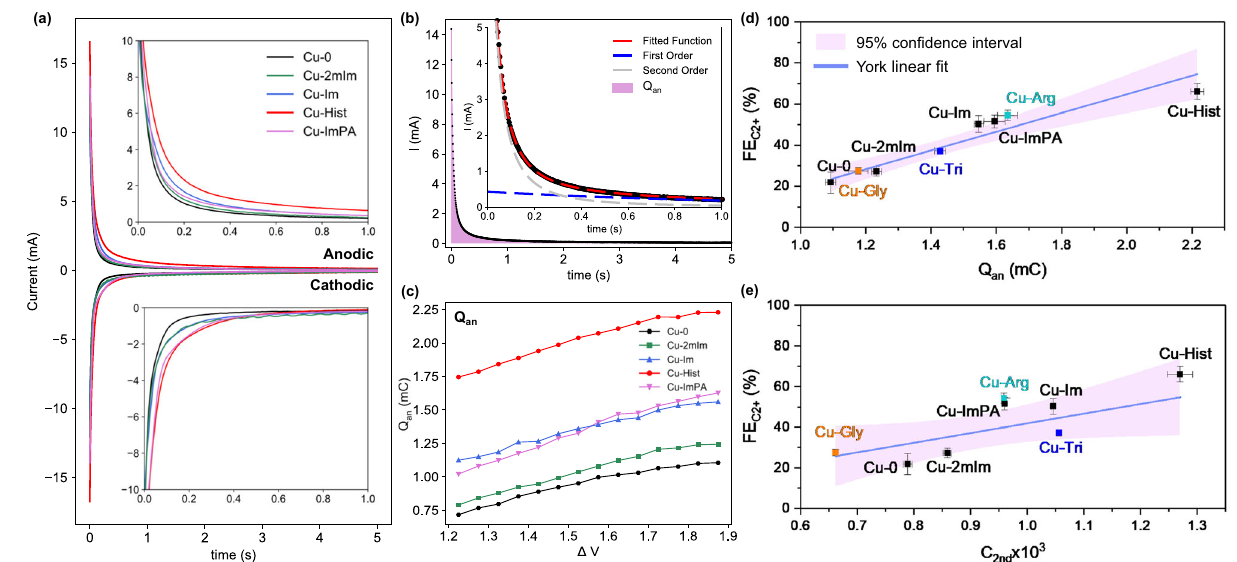
Fig. 7 | Evaluation of organic functionalised Cu catalysts using mPV measure- mentatcatalysis-relevantDCpotentials.a ThetransientcurrentresponsesofCu- 0 and four organic functionalised samples at Δ V =1.8V, showing transient anodic and cathodic current responses immediately after the applied voltage pulse. b Detailed view of transient anodic pulse for Cu-0 at Δ V =1.8. Shaded area repre- sents the integrated transient anodic current decay ( Q an ). Broken blue and grey lines represent the 1st and 2nd order decay equation fi tting respectively, and the composite function is represented by broken red lines. Insets in a and b show